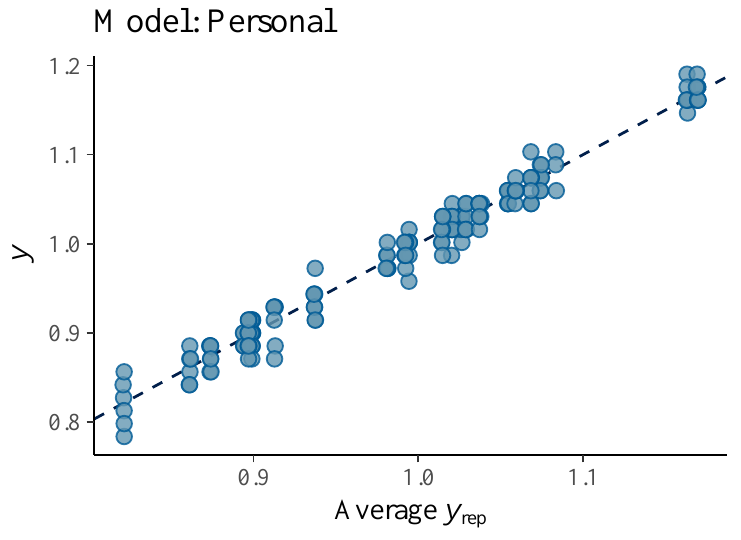
Figure 5. Ball velocity observations (dots) vs. average simulated value of the ball velocity (line) from the posterior predictive distribution of the Personal model. This graphical representation suggests that Personal model is a good fit to collected